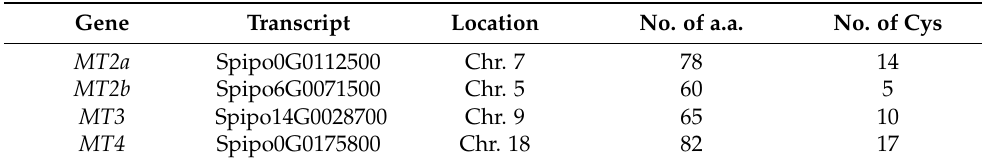
Figure 1. Identification of MT-like genes from S. polyrhiza : ( a ) alignment of predicted amino acid sequences of S. polyrhiza MT homologs against representative vascular-plant MTs; ( b ) a neighbor- joining tree based on the sequence alignment, with bootstrap values from 1000 iterations. Cysteine residues are highlighted in black. Arrows indicate the S. polyrhiza MT homologs. The accession numbers of the sequences used in the analysis are: AtMT1a (837273), OsMT1 (U43529), PsMT1 (BAD18382), LpMT (JZ977403.1), WaMT (JK990501.1), AtMT2a (820098), OsMT2a (P94029), PsMT2a (BAD18383), AtMT3 (820772), OsMT3a (A1YTM8), AtMT4a (818800), and OsMT4 (Q109B0). Table 1. Annotation of S. polyrhiza MT-like